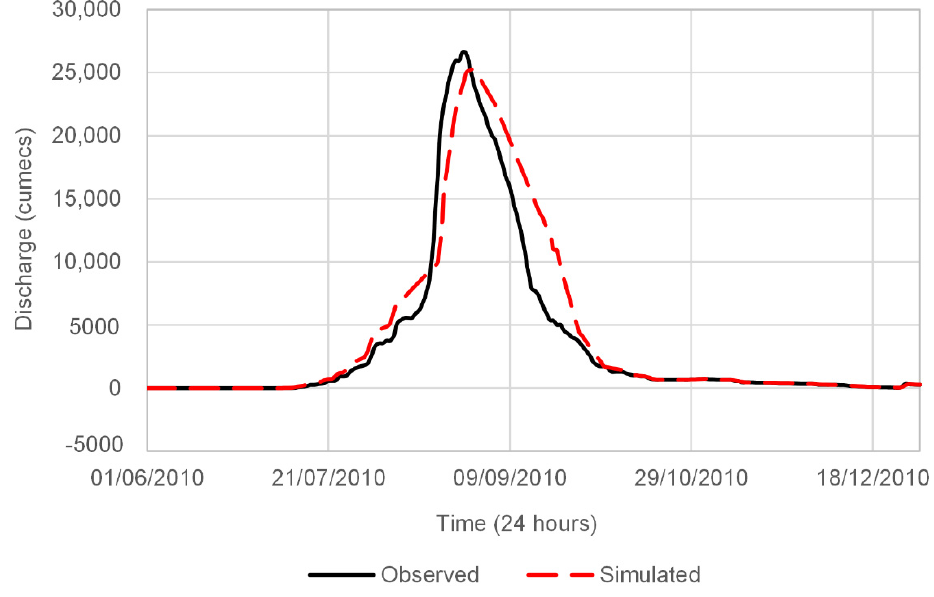
Figure 8. Calibration of the hydraulic model by comparing the observed and simulated flow hydro- graph of the 2010 flood downstream of the Kotri Barrage. 20.020.521.021.522.022.523.0 Figure 9. Validation of the hydraulic model by comparing the observed and simulated high water- marks of the 2010 flood downstream of the Kotri Barrage. 3.4. Sediment Deposits Impact Assessment The scenario-based impact assessment of sediment deposits on the flow regime in the study area river-reach was completed employing the middle braiding cross-sections (Figure 10) for the floodplain system in the HEC-RAS model. It is interpreted coupling remotely sensed imagery and field data of morphologically active channels. Figure 10 compares three middle river-reach x-sections, simulated for the flood years of 1994 and 2010 through an iterative process in the HEC-RAS 1D-unsteady flow analysis model, while observed for the year 2018. They clearly show the vertical profile of the braiding river from three ditch channels in 1994 to two active layers in 2010, and eventually reshaped to one mor-